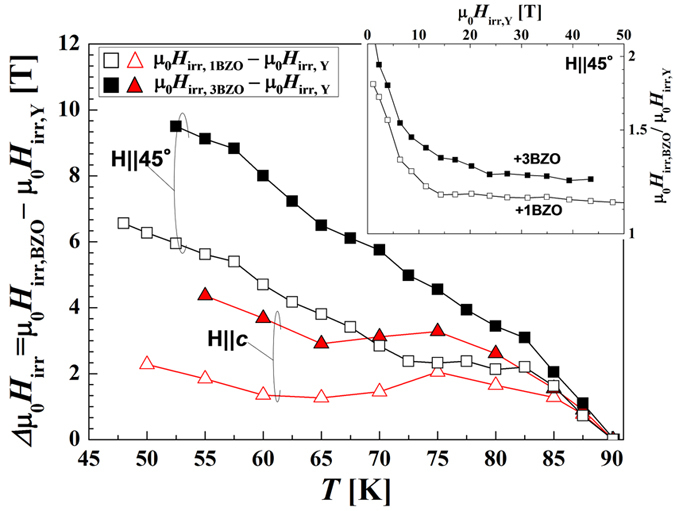
Temperature dependence of Hirr enhancement.Temperature dependence of Δμ0Hirr = μ0Hirr,BZO−μ0Hirr,Y at H||c and H||45° for +1BZO and +3BZO wires. The inset shows the ratio of μ0Hirr,BZO/μ0Hirr,Y for + 1 and + 3BZO for H||45°.